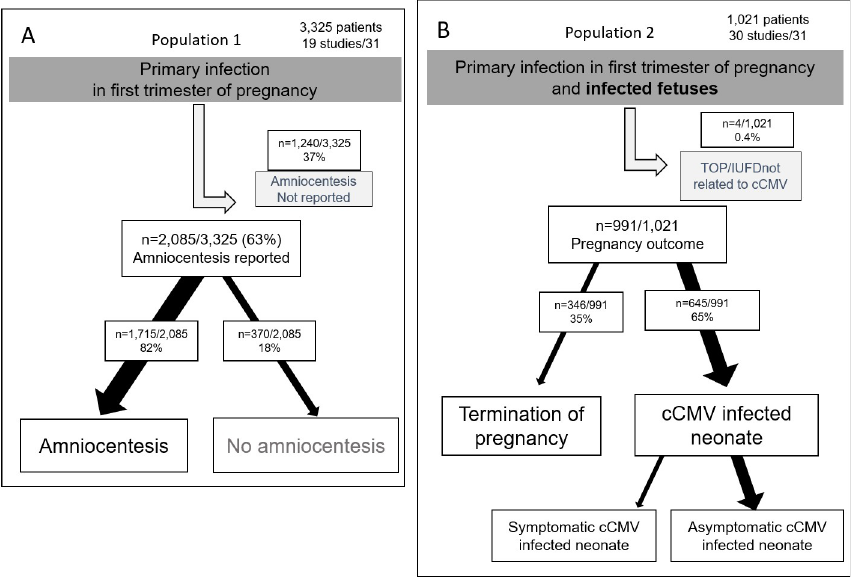
Fig 2. Population flowchart. Population was divided into two categories of population: A) population 1, with pregnant women before amniocentesis and B) population 2, after positive amniocentesis. The thickness of the arrows is proportional to the number of